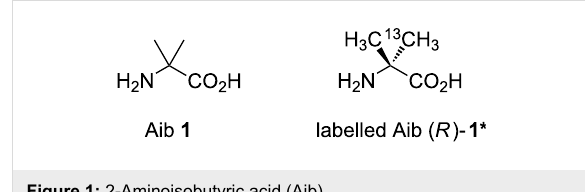
Figure 1: 2-Aminoisobutyric acid